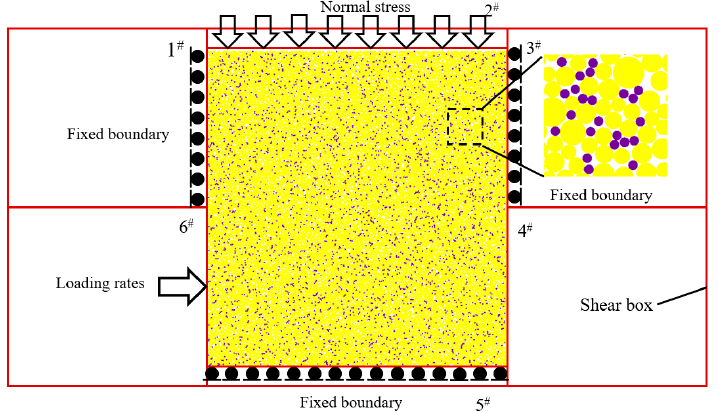
Figure 9. Direct shear discrete element numerical model and microstructure of gas hydrate deposits.